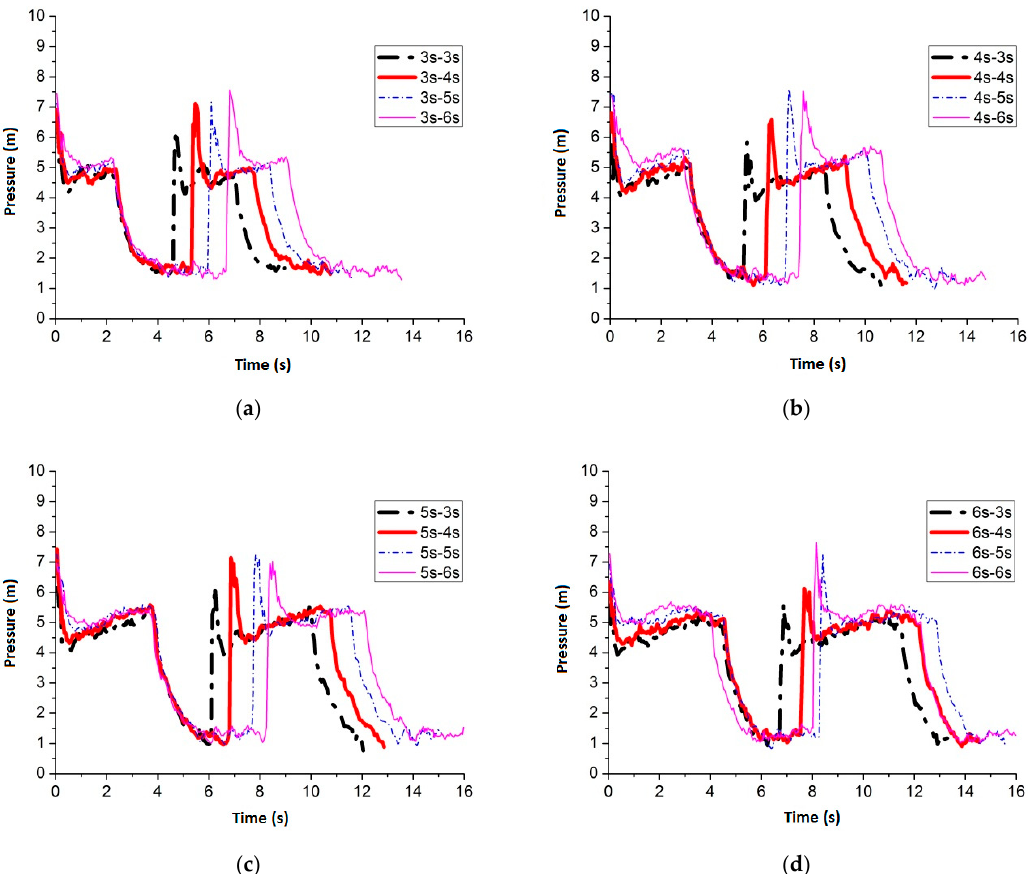
Figure 24. Pressure fluctuation of No. 1 sensing point when the slot nozzle is set on top of the pipe ( a ) air inflow time is 3 s; ( b ) air inflow time is 4 s; ( c ) air inflow time is 5 s; and ( d ) air inflow time is 6 s.